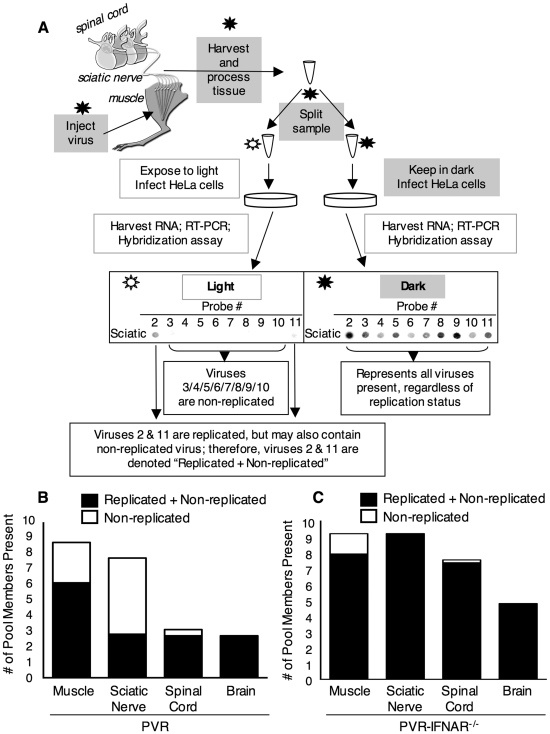
Replication status for individual viral population members.(A) Schematic of light-sensitive/neutral red poliovirus hybridization-based diversity assay for determining viral replication status. In the dark (using a red safety light; black star/grey boxes), the 10 marked viruses containing neutral red dye were intramuscularly injected into the left gastrocnemius muscle of PVR or PVR-IFNAR−/− mice. At 72 hpi, tissues were harvested and processed in the dark. The viral sample for each individual tissue was split, and half of the sample was exposed to light to inactivate non-replicated virus (unfilled star/unfilled boxes), and the other half of the sample was kept in the dark. Both virus samples were amplified by a single cycle of replication in HeLa cells to expand surviving virus and decrease the prevalence of light-inactivated virus. Total RNA was extracted, and the tagged region of the viral genome was amplified by RT-PCR. DNA was then spotted on a membrane, and the viral diversity assay was performed. Signal for each virus from the light-exposed and non-light exposed samples was compared for each tissue; sciatic nerve from a representative mouse is shown as an example. Light-sensitive viruses were scored as ‘Non-replicated’ (in this case, viruses 3/4/5/6/7/8/9/10), and light-insensitive viruses were scored as ‘Replicated+Non-replicated’ (in this case, viruses 2 and 11) because they may contain a sub-population of non-replicated viruses, which would be masked by the signal from replicated viruses. Pooled results from each tissue for 10 PVR mice (B) and 5 PVR-IFNAR−/− mice (C) are shown. Bars represent the mean diversity in each tissue, and the proportion of non-replicated virus is indicated (unfilled bar).